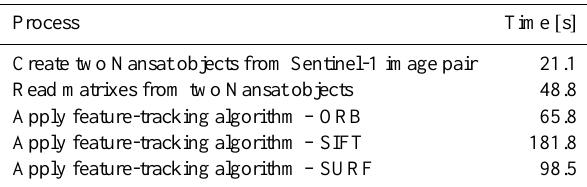
Table 3. Processing times for sea ice drift computation from one